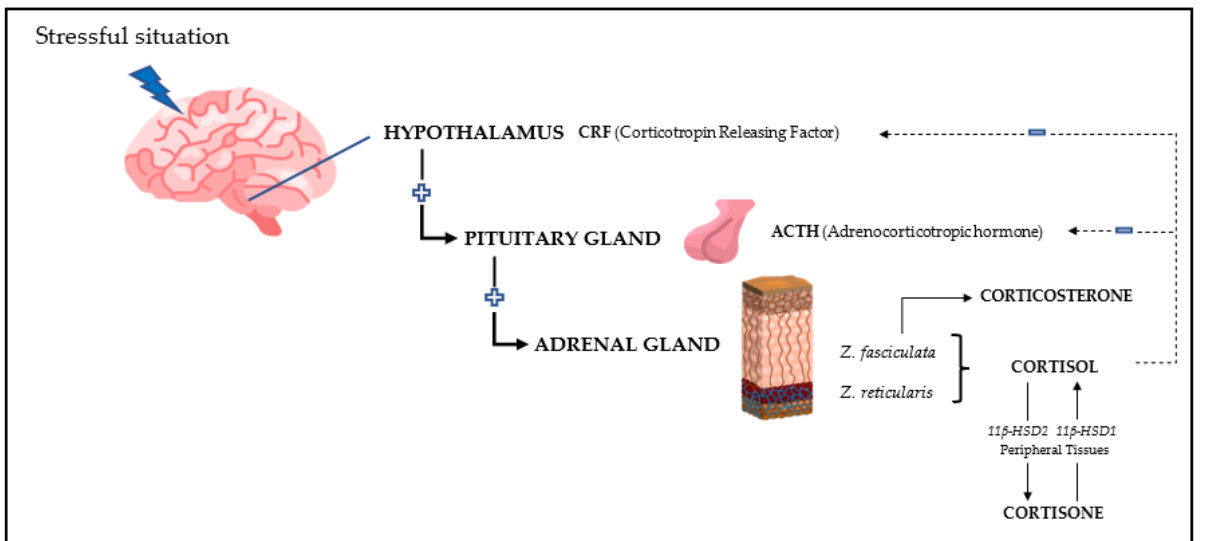
Figure 1. Schematic representation of glucocorticoid release following a stressful situation.